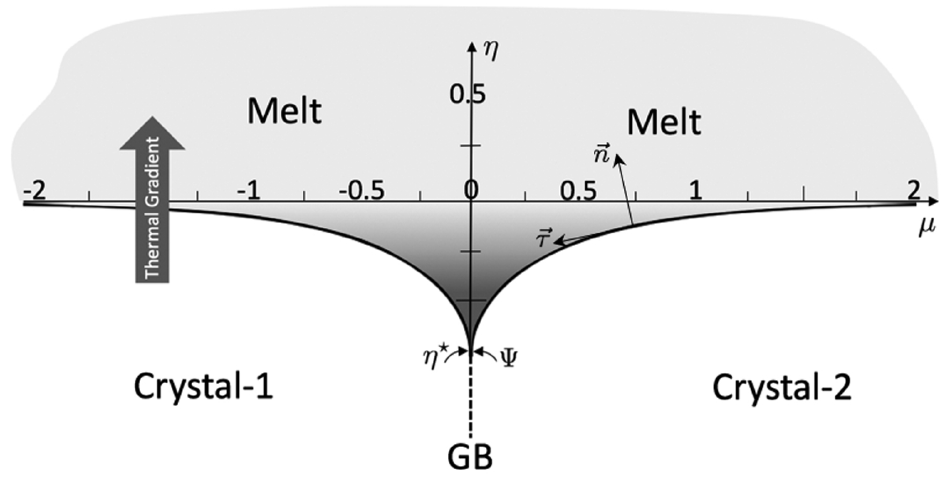
Figure 2. Variational grain boundary groove profile with its dihedral angle, Ψ = 0. The profile’s dimensionless Cartesian coordinates, ( µ , η ) and its normal ( (cid:126) n ) and tangent ( (cid:126) τ ) vectors are displayed. The µ -axis is coincident with the system’s melting point isotherm, T = T m , insuring that stable melt (light gray) exists where η > 0, and stable solid (white areas) exists where η < 0. Undercooled melt (indicated by increasingly darker grays) and curved solid co-exist within the lower half-plane beneath the µ -axis. Local equilibrium is maintained by matching the thermo-chemical potential at each point along the solid–liquid interface. Both curvature and temperature vary with depth for this groove in the limited sub-space between the µ -axis ( η = 0) and the groove’s triple junction located at η (cid:63) = which is the deepest cusp allowed for a variational groove in